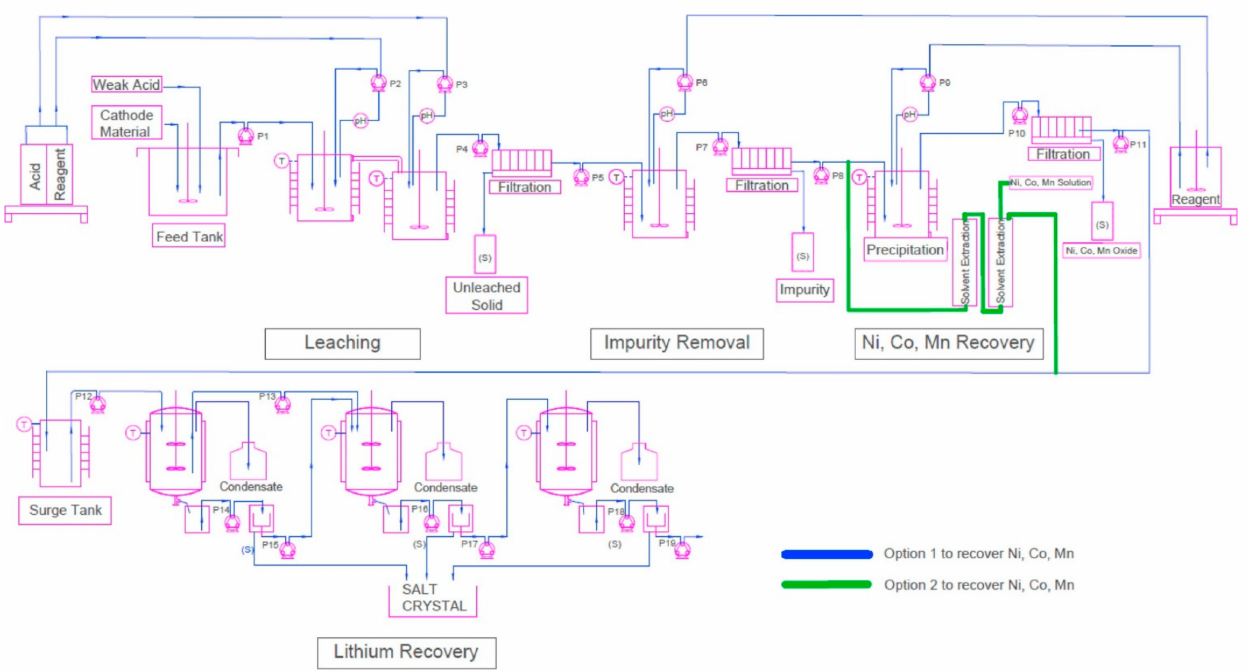
Figure 7. Schematic of the hydrometallurgy process for recycling battery cathode materials [58]. Reprinted from Journal of Energy Storage, Vol. 35, J. C. Y. Jung, P. C. Sui, and J. Zhang, A review of recycling spent lithium-ion battery cathode materials using hydrometallurgical treatments, Copyright (2021), with permission from